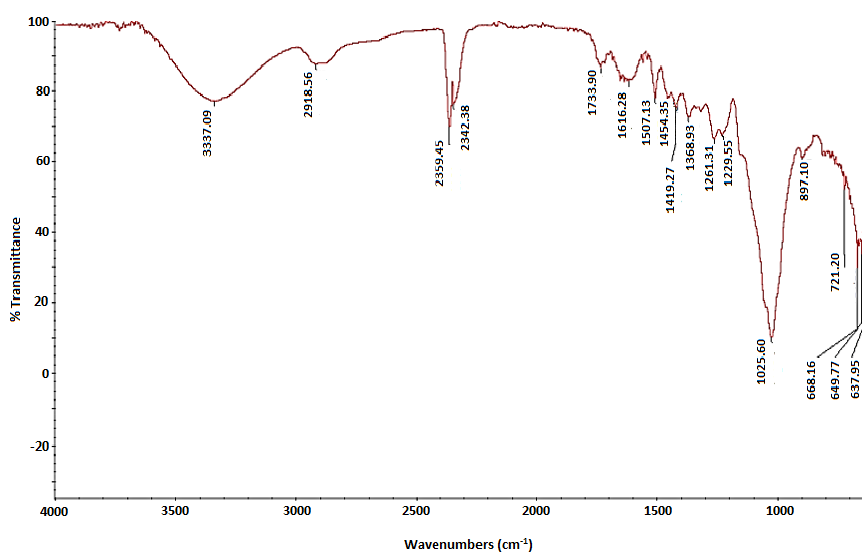
Figure 4. Fourier ‐ transform infrared spectroscopy (FTIR) peaks for Acacia tortilis.